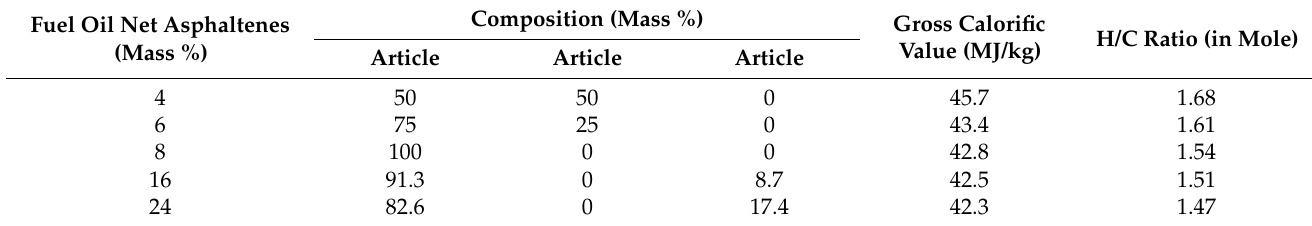
Table 1. Properties of the fuel samples used in this